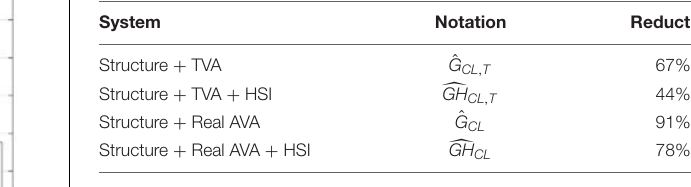
TABLE 2 | Reduction of H ∞ norm considering uncertainties.